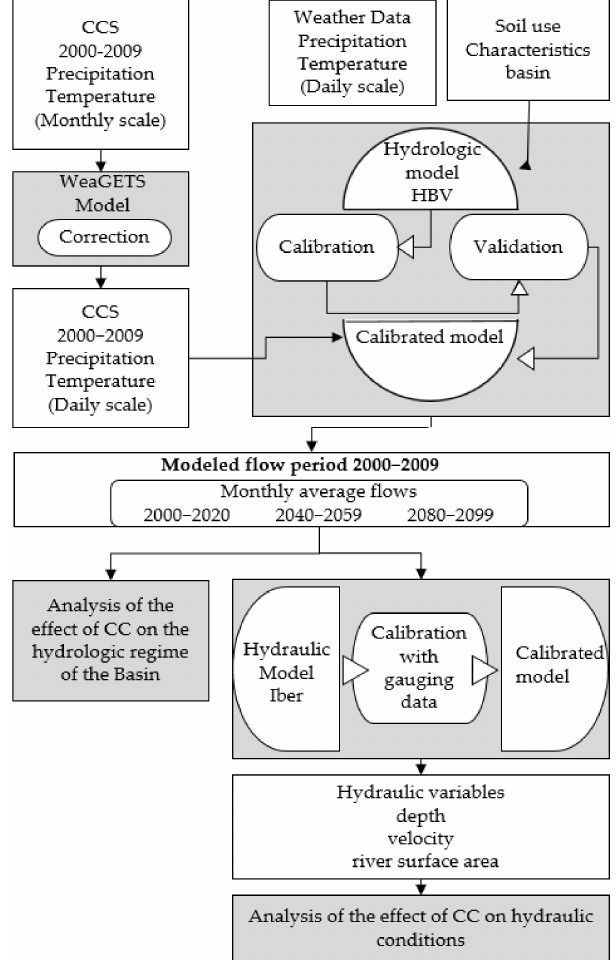
Figure 3. Project flow